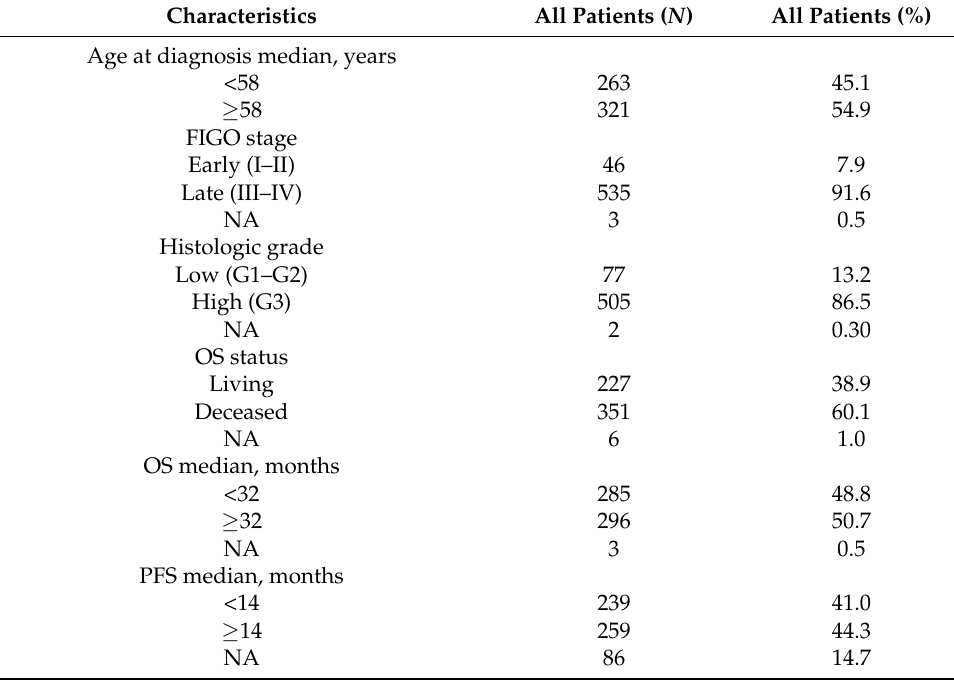
Table 1. Summary of clinical and pathological characteristics of 584 serous ovarian cancer patients from TCGA-OV